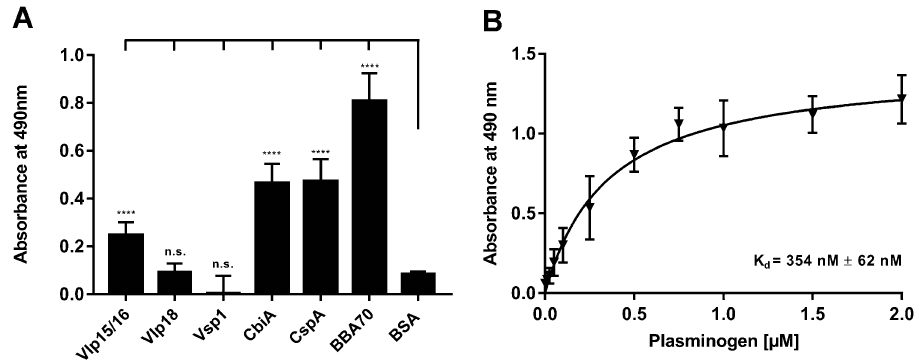
Figure 1. Identification of plasminogen-binding proteins in B. miyamotoi . ( A ) Binding of plasminogen to recombinant proteins by ELISA. Vlp15/16, Vlp18, Vsp1, CbiA, CspA, BBA70, and BSA (5 µg/ml each) immobilized were incubated with 10 µg/ml plasminogen. Bound plasminogen was detected using a polyclonal antibody. ( B ) Dose-dependent binding of plasminogen to Vlp15/16. Vlp15/16 (5 µg/ml) were immobilized and incubated with increasing concentrations of plasminogen. Binding curve and dissociation constant were approximated via non-linear regression, using a one-site, specific binding model using GraphPad Prism version 7. Data represent means and standard deviation of at least three different experiments, each conducted in triplicate. ****p ≤ 0.0001, n.s., no statistical significance, one-way ANOVA with post-hoc Bonferroni multiple comparison test (confidence interval =